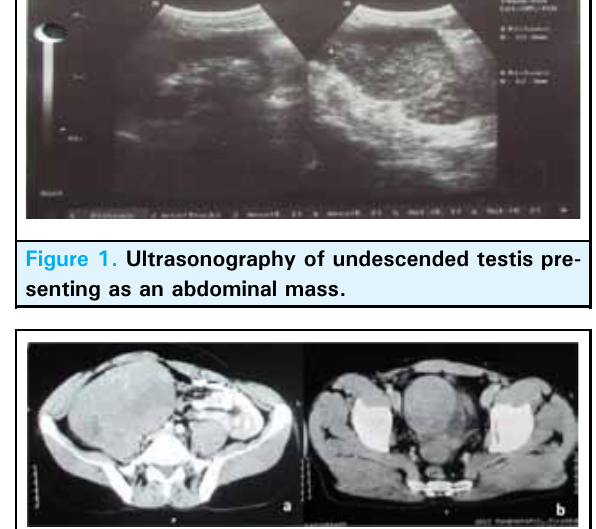
Figure 2. ct scan showing the mass in the right (2a) and left (2b) iliac foss.